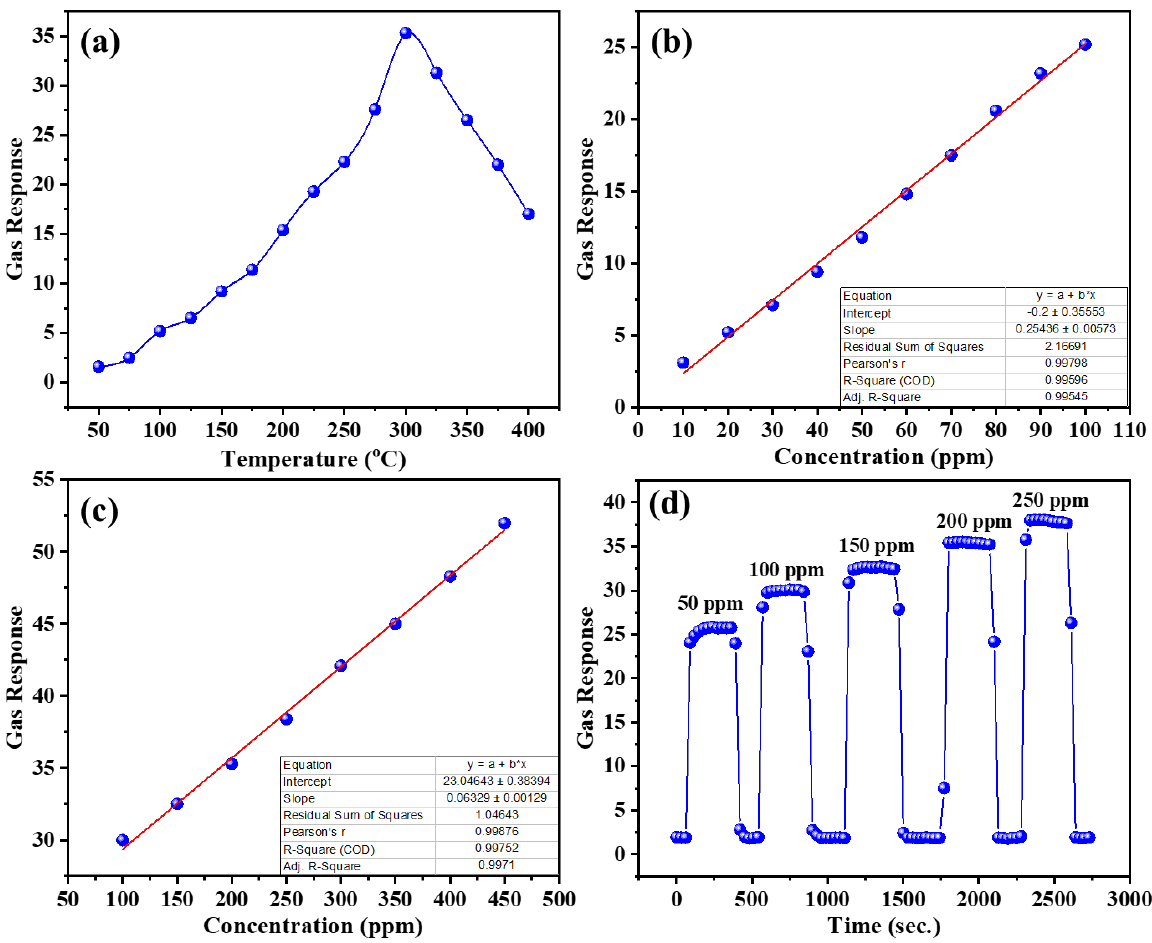
Figure 5. ( a ) Gas sensor response to 200 ppm H 2 S gas as a function of the operating temperature, ( b , c ) dependency of gas sensor response on low and high concentration, respectively for H 2 S gas at optimized temperature and ( d ) Dynamic response plots for leaf-shaped CuO nanosheets based H 2 S gas sensor.